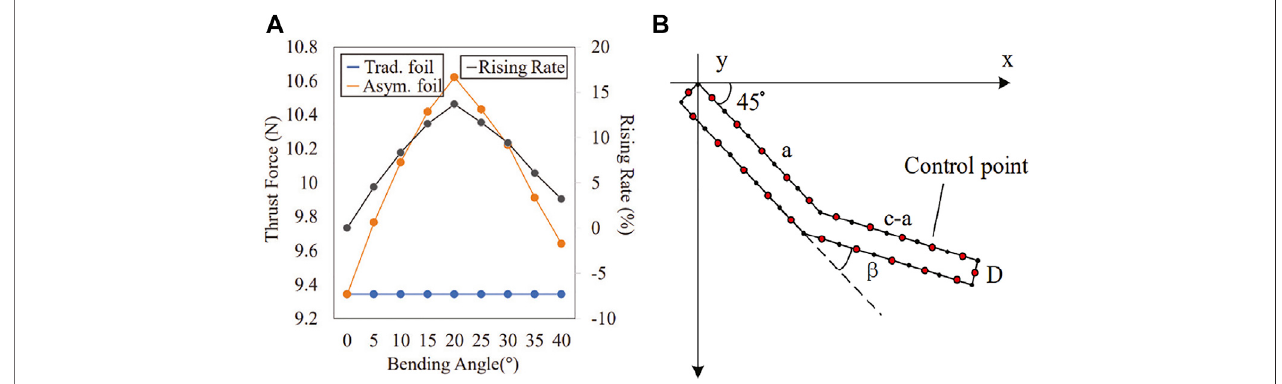
FIGURE4| Fluidregionandfoilssetupofthesimulations.Thesizeofthe fl uid region: X-55 cm , Y-65 cm , Z-100 cm . The boundaries of the fl uid region are set asfollows: XMIN-Symmetry, XMAX-Symmetry, YMIN-Out fl ow, YMAX- speci fi ed velocity, ZMIN-Symmetry, ZMAX-Symmetry.